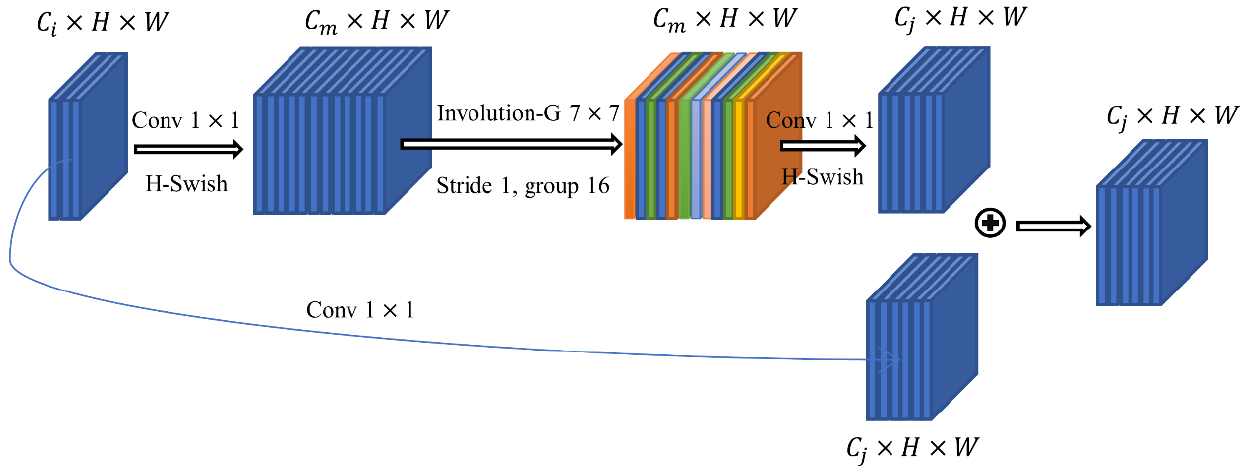
Figure 4. Structure of the REI module.